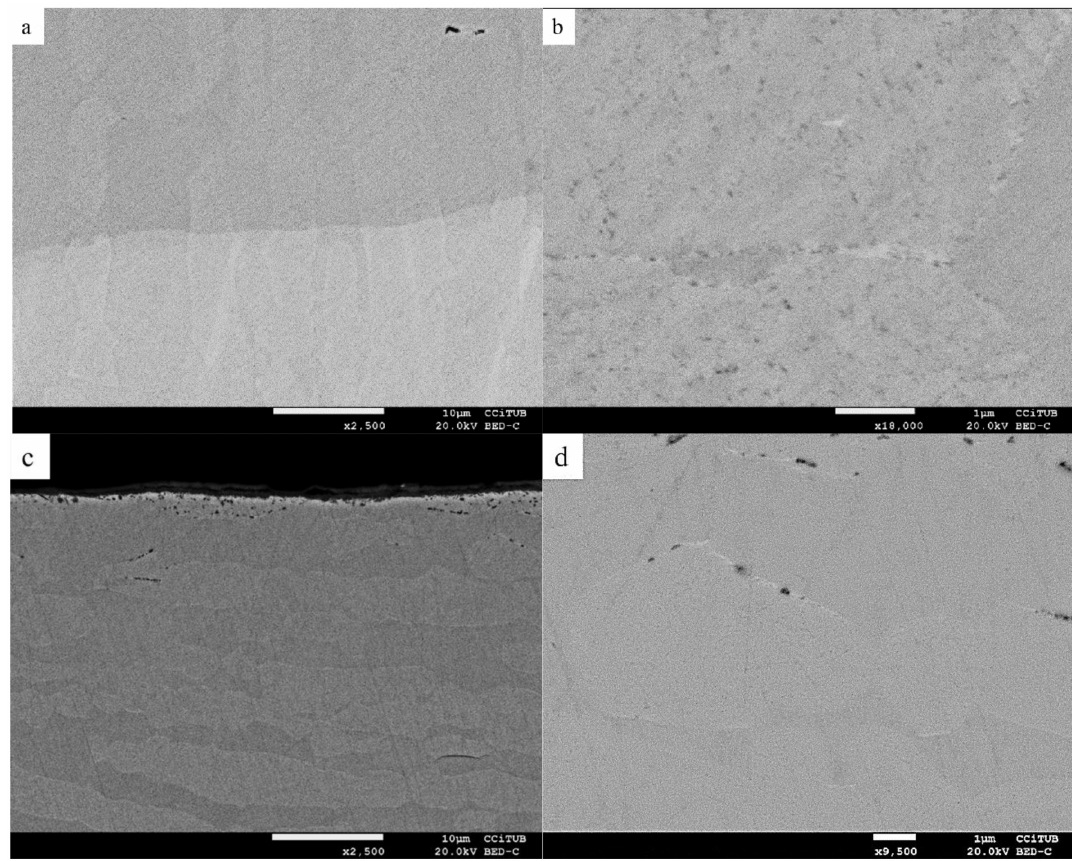
Figure 2. BSE micrographs of the SDSS plate and the SDSS tube samples after 10 h plasma nitriding at 520 ◦ C and post heat treatment at 830 ◦ C for up to 3 min. ( a ) Cross-section of the SDSS plate sample. ( b ) Higher magnification of ( a ). ( c ) Longitudinal section of the SDSS tube after 10 h, and ( d ) higher magnification of ( c